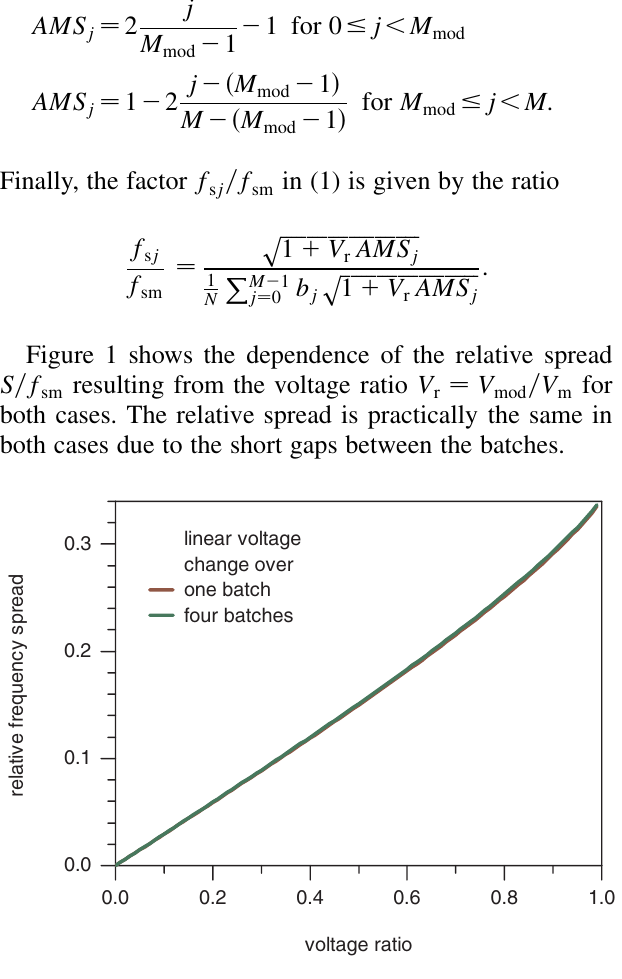
FIG. 2. Additional relative incoherent frequency spread during the SPS cycle, supplied by the 800 MHz rf